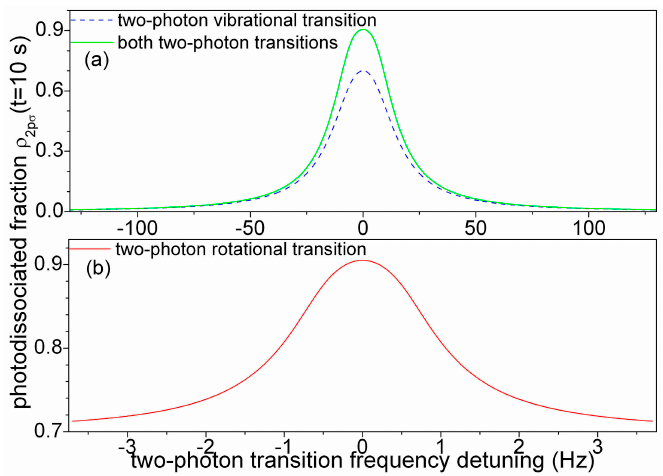
Figure 4. ( a ) Spectra of the two-photon rovibrational transition calculated with (green continuous line) or without (blue dotted line) THz-wave tuned at the two-photon rotational resonance. ( b ) Spectrum of the two-photon rotational transition (red continuous line) at the two-photon rovibrational resonance.